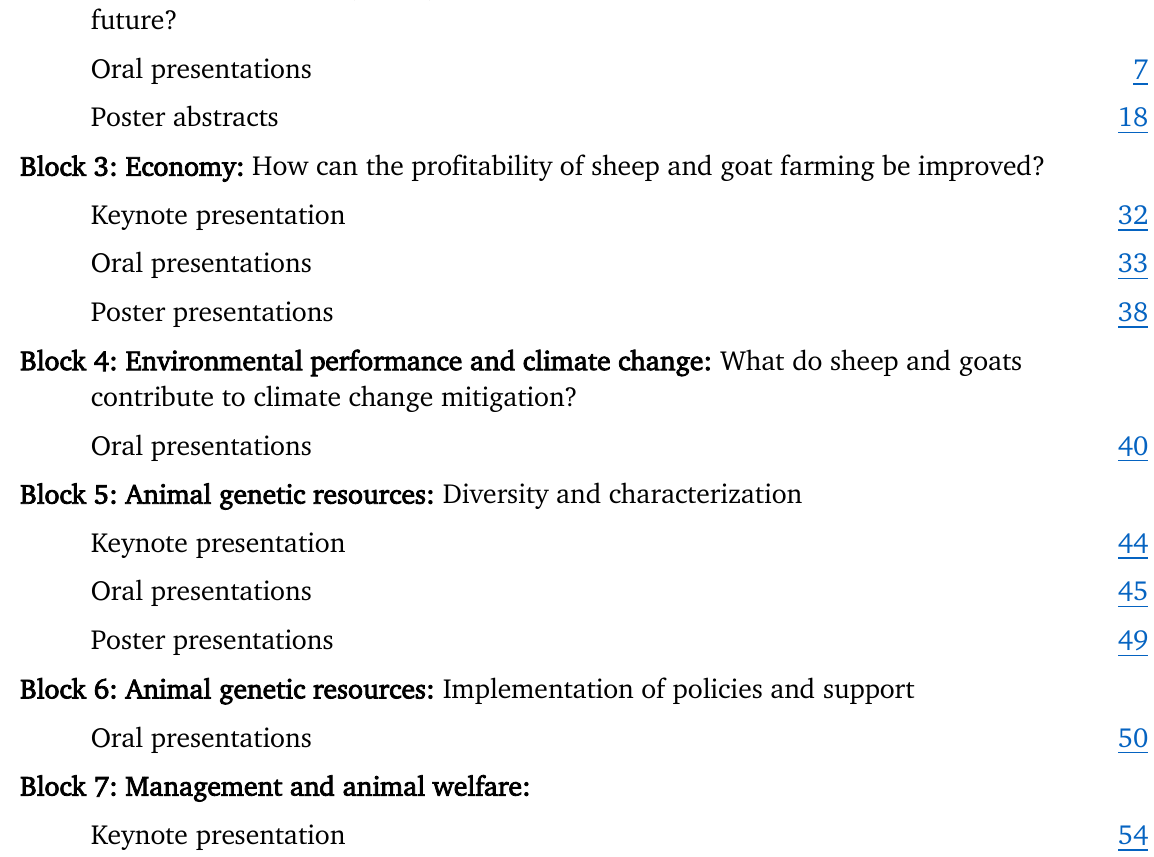
Scientific Program Group Editorial Congress